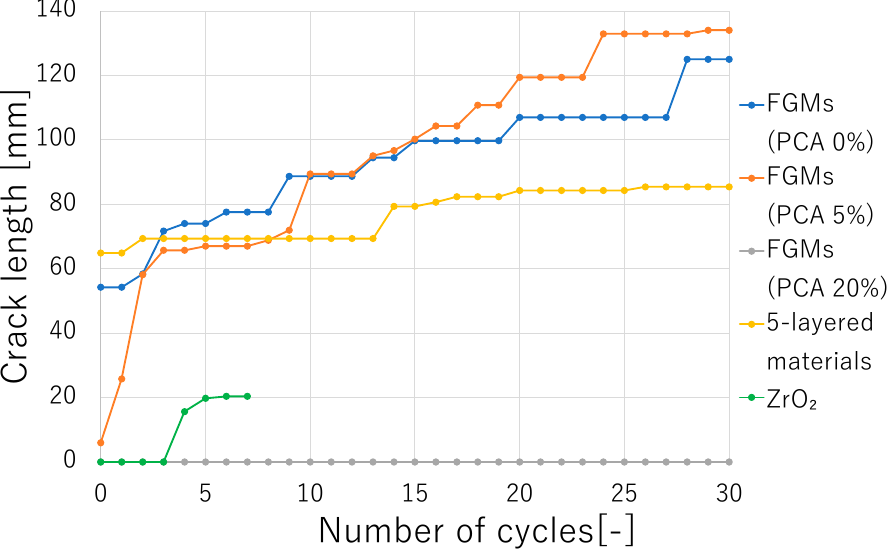
Figure 14. Crack propagation on ZrO 2 -rich surfaces in FGMs with the rotating speed of 250 rpm with PCA (0%, 5% and 20%), 5-layered materials and ZrO 2 single layer materials under cyclic thermal shock loadings.